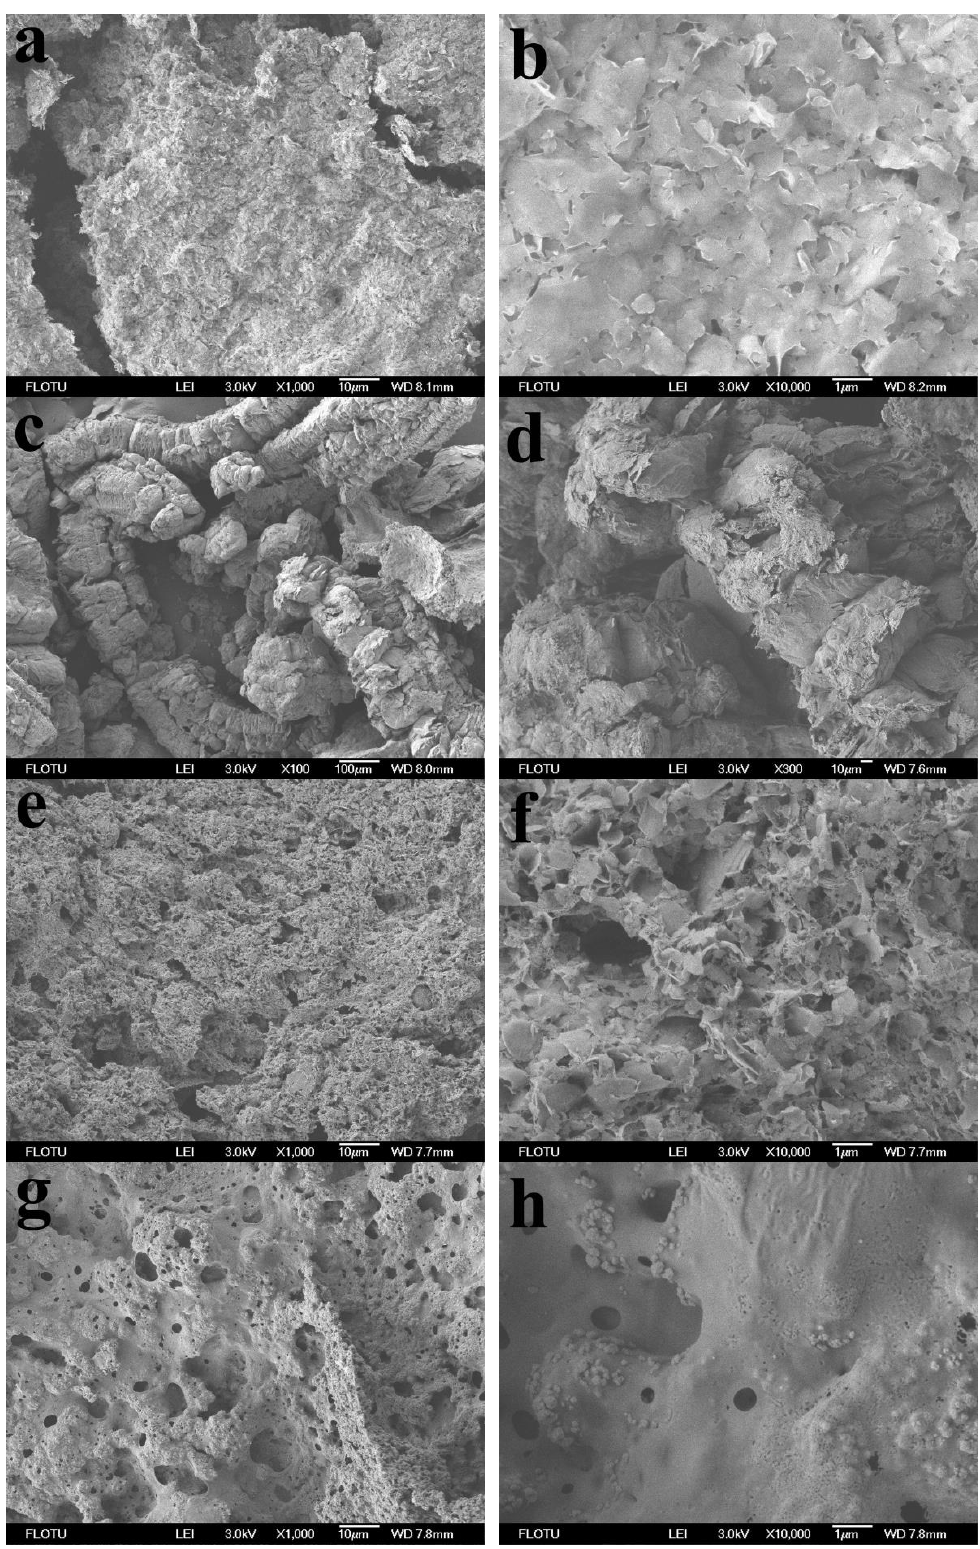
Figure 7. Field emission scanning electron microscopy (FESEM) micrographs of SSPCM residues after the cone calorimeter tests: ( a , b ) PCM, ( c , d ) PCM-EG, ( e , f ) PCM-RP and ( g , h ) PCM-IFR.